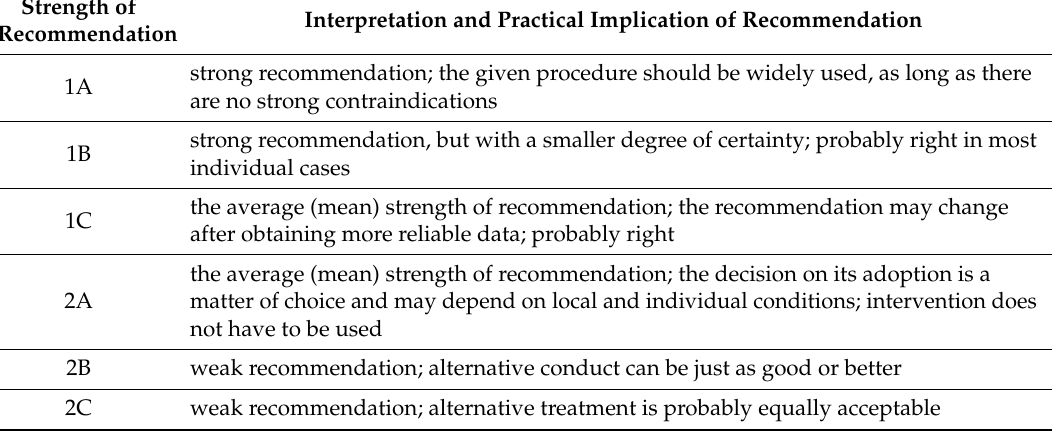
Table 3. Strength of recommendations and its practical